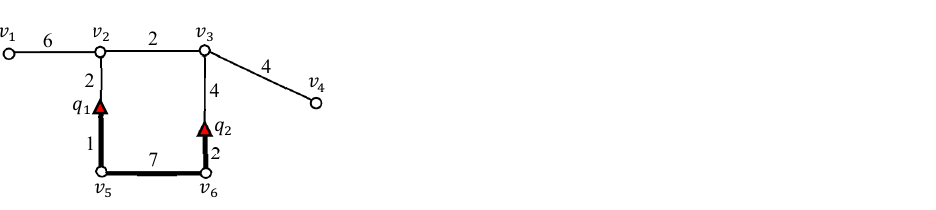
Figure 3. Difference between dist ( q 1 , q 2 ) = 8 and len ( q 1 v 5 v 6 q 2 ) =